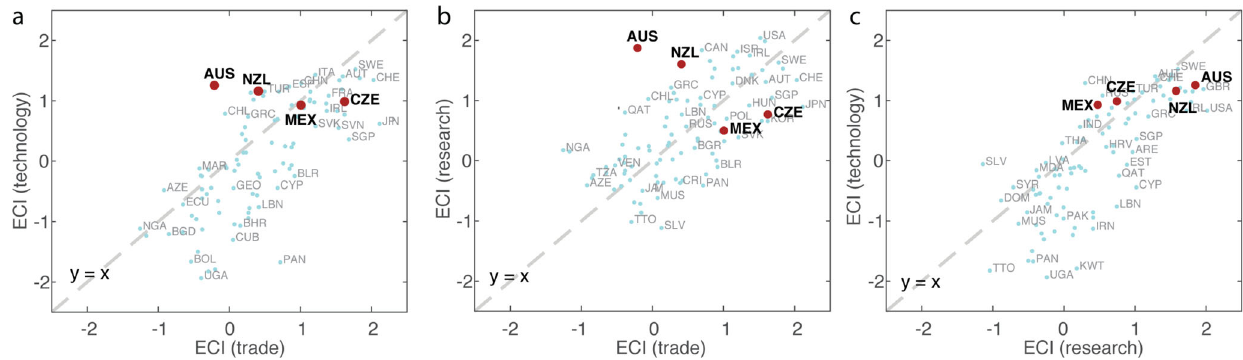
Fig. 2 Comparison between trade, technology, and complexity ECI using 2014 data. a Scatterplot for the relationships between ECI (trade) and ECI (technology) ( R 2 = 0.51, p -value < 10 − 12 ), b ECI (trade) and ECI (research) ( R 2 = 0.44, p -value < 10 − 12 ), and c ECI (research) and ECI (technology) ( R 2 = 0.54, p -value < 10 − 1 2